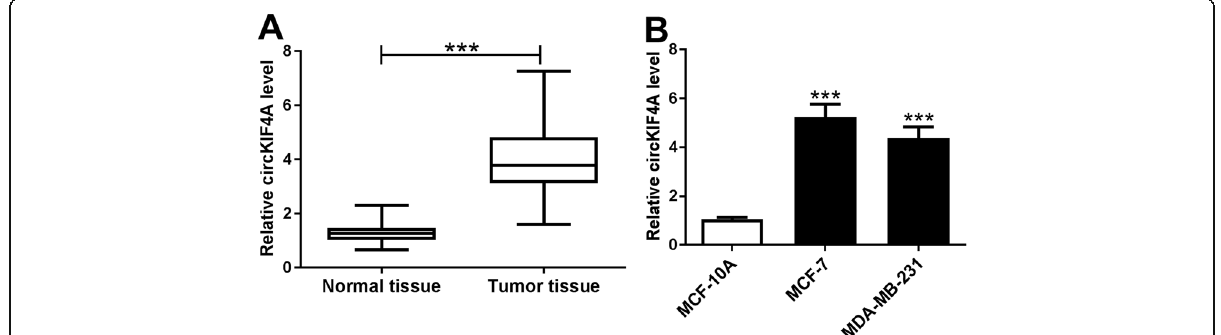
Fig. 1 High expression of circKIF4A in BC tissues and cells. ( a ) The level of circKIF4A in BC tissues and normal tissues was evaluated using qRT- PCR. ( b ) The expression of circKIF4A in MCF-7, MDA-MB-231 and MCF-10A cells was determined using qRT-PCR. ***P <